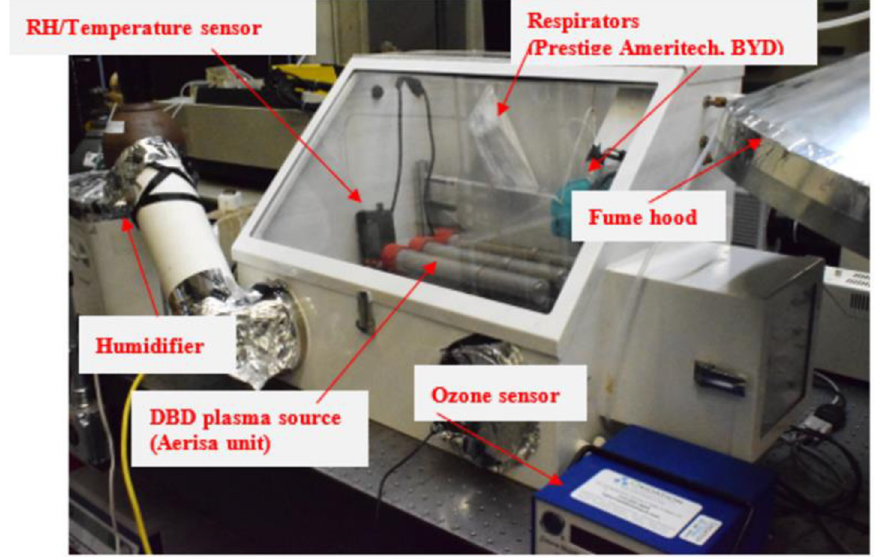
Fig 4. Schematic view of glove box testing